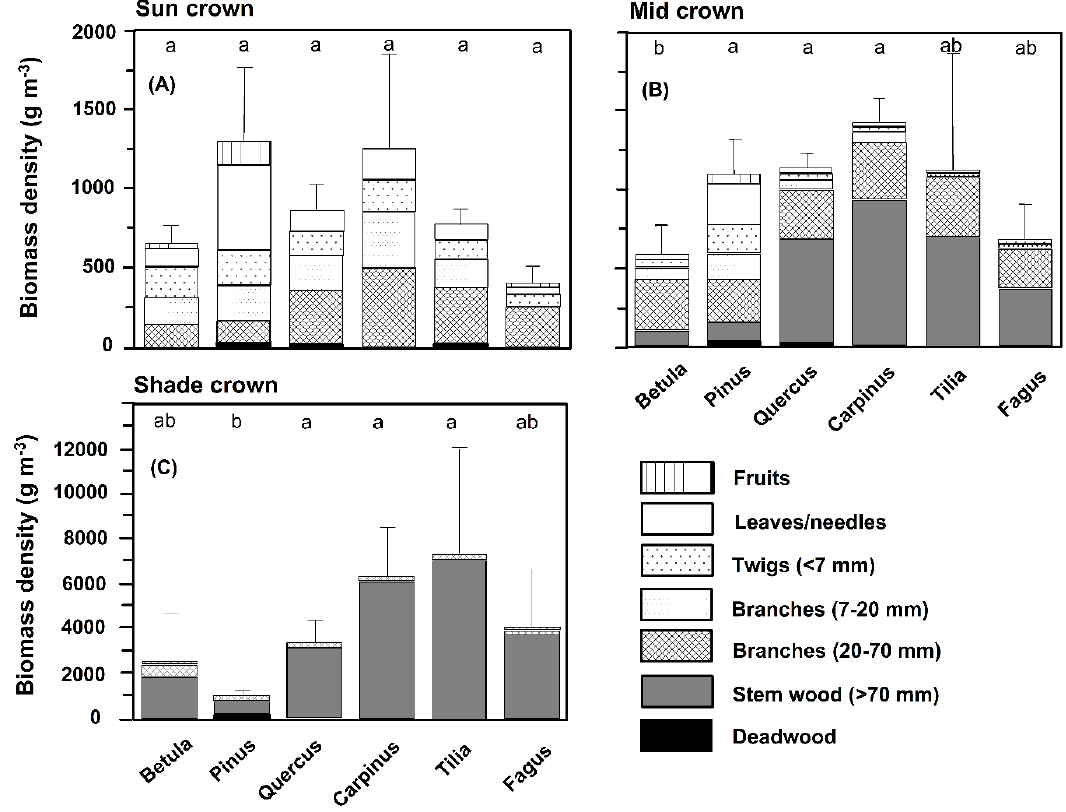
Figure 2. Biomass per unit crown volume in the sun ( A ), mid ( B ), and shade crown ( C ) of the six species by biomass fraction (means and standard deviation of each four harvested trees [Fagus: N = 9]). Deadwood refers to dead branches attached to the stem. Significantly different means between species are marked by different small letters.